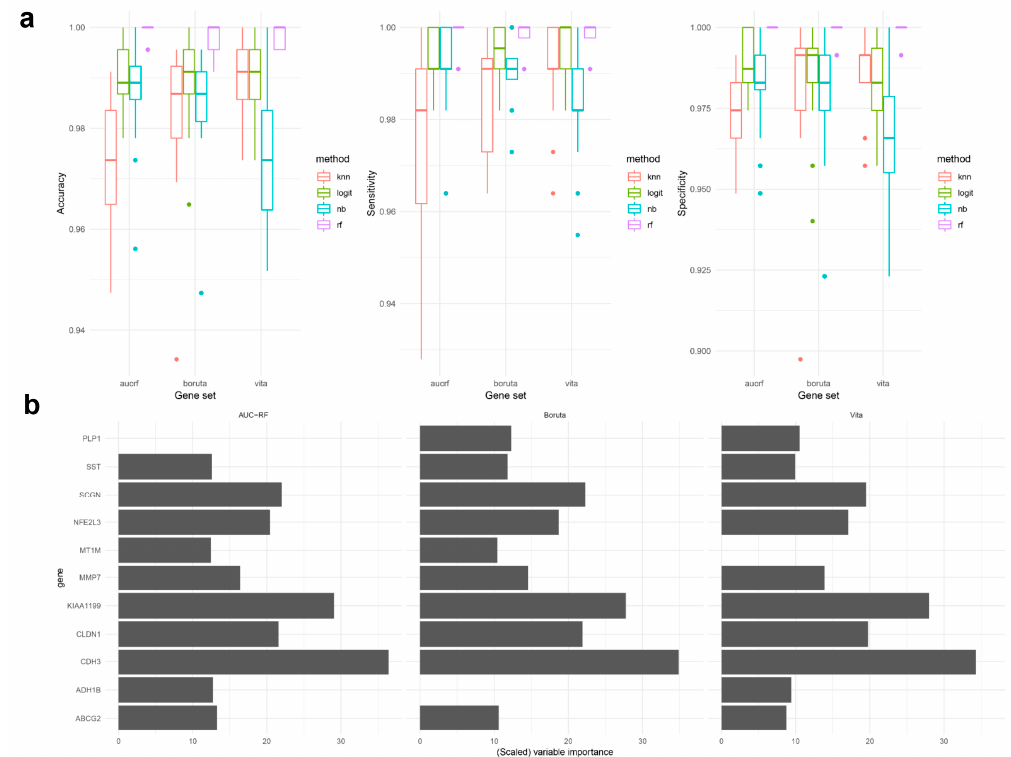
Figure 4. Performance metrics of classification models and variable importance scores from three tested signatures. ( a ) Accuracy, sensitivity, and specificity of various machine learning classification models. ( b ) Top 10 most important candidates of the random forests models.